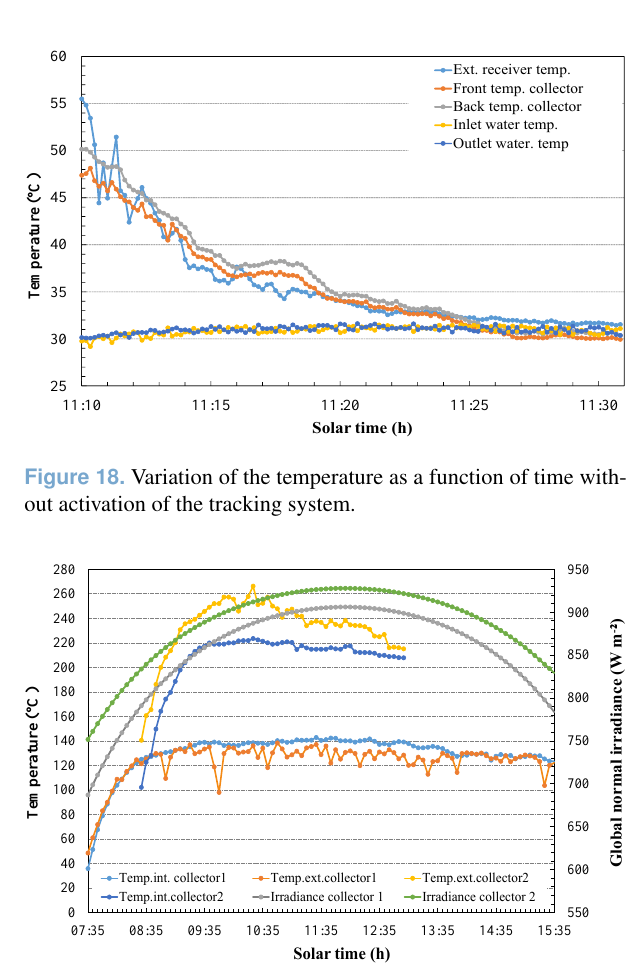
Figure 19. Variation of the internal and external receiver tempera- ture (without water